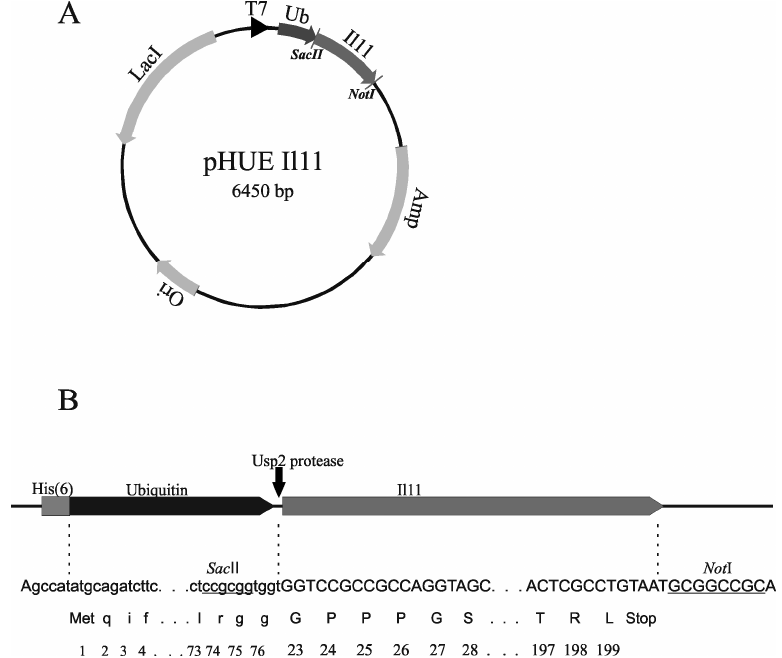
Figure 2. ( A ) Plasmid map of pHUE IL-11 vector showing the Ub coding region (black arrow), the IL-11 coding region (grey arrow), the T7 RNA polymerase promoter (black triangle) and other regions (shaded arrows), including ColE1 origin of replication (Ori), LacI repressor (LacI) and β -lactamase (Amp) genes. Arrows indicate the direction of transcription. The SacII/NotI restriction sites used for cloning of IL-11 gene are shown; ( B ) The schematic presentation of the Ub-IL-11 fusion protein. The black arrow indicates the site of hydrolysis by Usp2 protease. The nucleotide sequences of the 5 ′ end and the restrictions sites (macaque IL-11) are shown. The translation into the protein sequence is shown below. The numbering of protein residues corresponds to the non-processed protein (Swiss-Prot entry P20808). Indeed, Escherichia coli ( E. coli ) cells are widely used for production of IL-11 as a mature protein lacking a signal peptide (human IL-11 [25,26]) or as a fusion protein (human [27–30] or murine IL-11